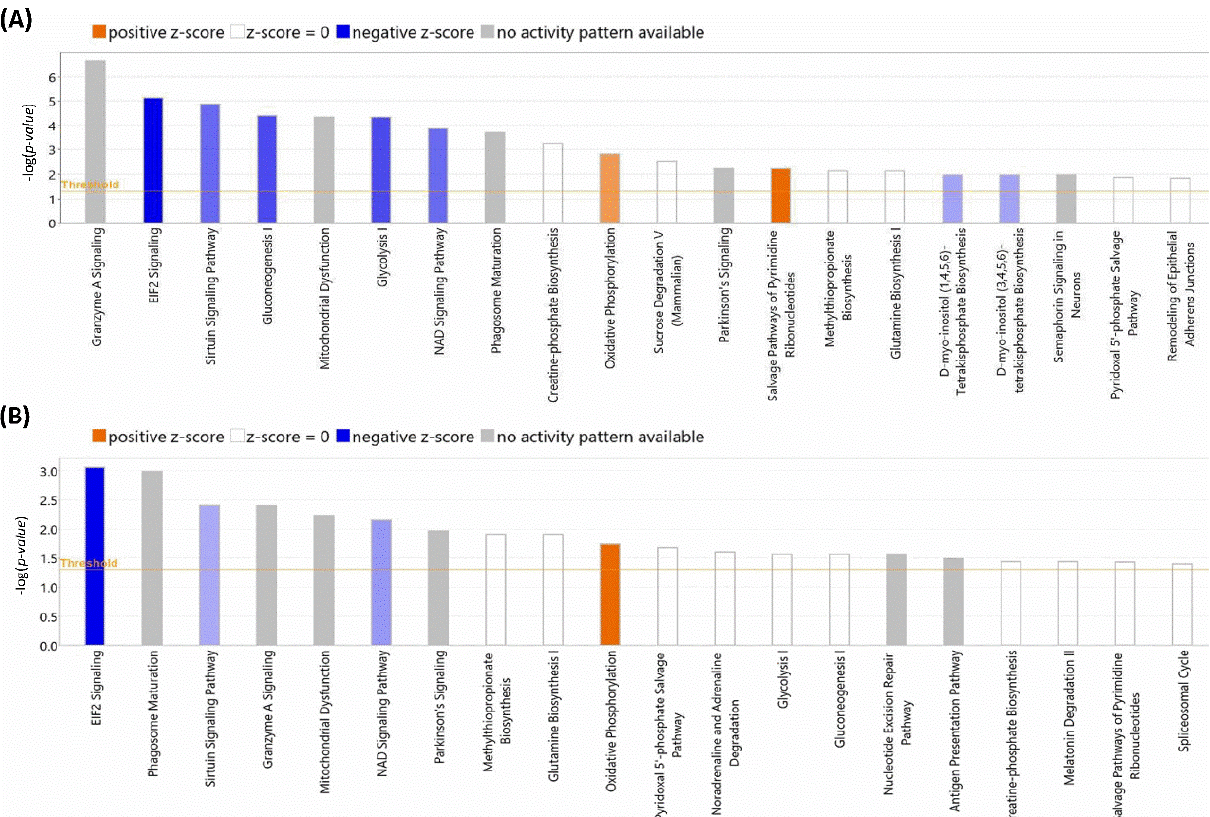
Figure 5. TOP-20 altered cellular processes detected by Ingenuity ® . ( A ) Processes altered according to the Ingenuity Full Database. ( B ) Processes altered according to the Ingenuity Heart and Cells Database. The size of the bars indicates the log ( p -value) of each alteration detected. Blue colors indicate downregulations and orange color indicates upregulations. Color intensity indicates the statistical confidence of each alteration. Grey color indicates that it is not possible to analyze the alteration character.